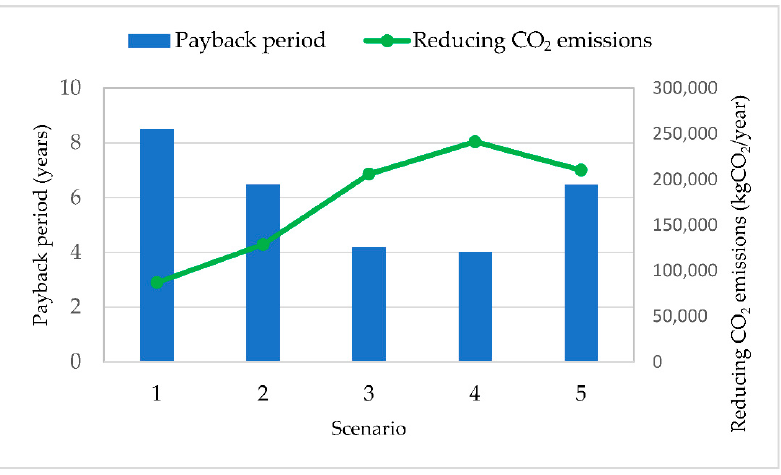
Figure 28. The payback period (PBP) and reducing CO 2